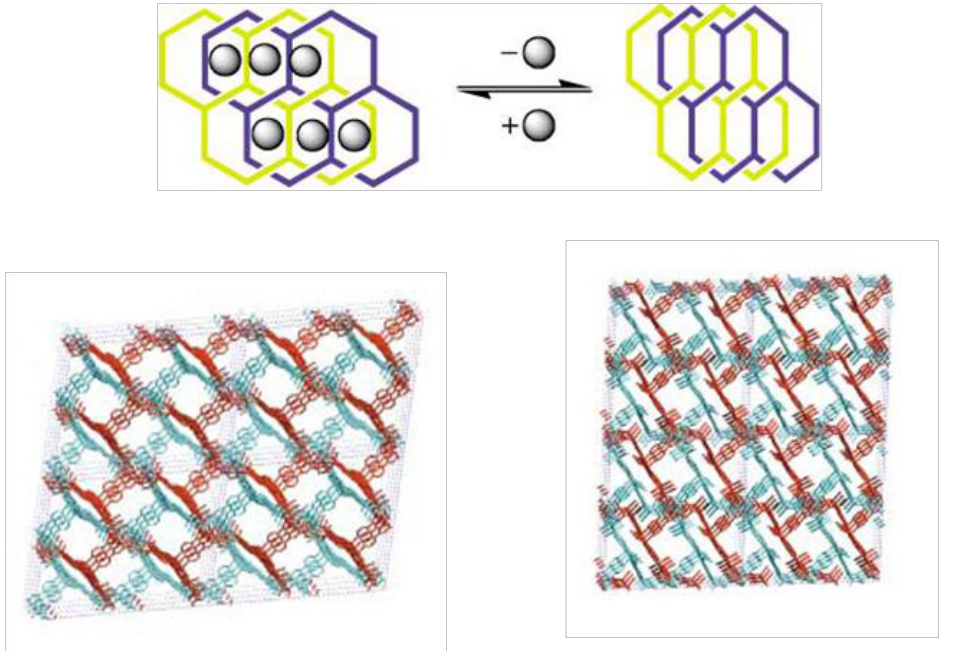
Figure 4. The crystal structure of {(ZnI ten molecules of TPT and ten Zn atoms. (Right) the interpenetrated framework viewed along the b -axis. C: gray, N: blue, Zn: magenta. Reprinted with permission from [23]. Copyright © 2002 WILEY-VCH Verlag GmbH & Co. KGaA, Weinheim.